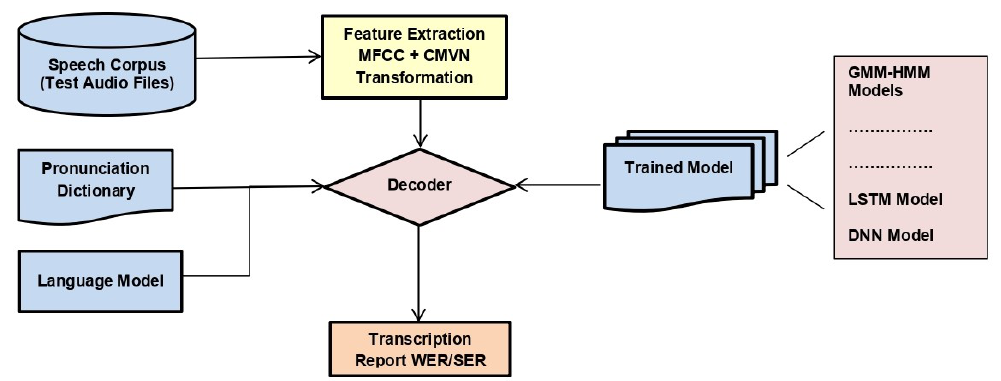
Figure 7. Model for decoding. WER, word error rate; SER, sentence error